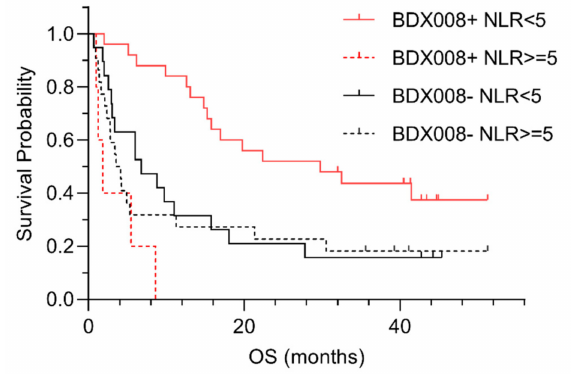
Figure 2. Kaplan–Meier plots of outcome data by BDX008 classification for patients in defined by neutrophil-to-lymphocyte ratio